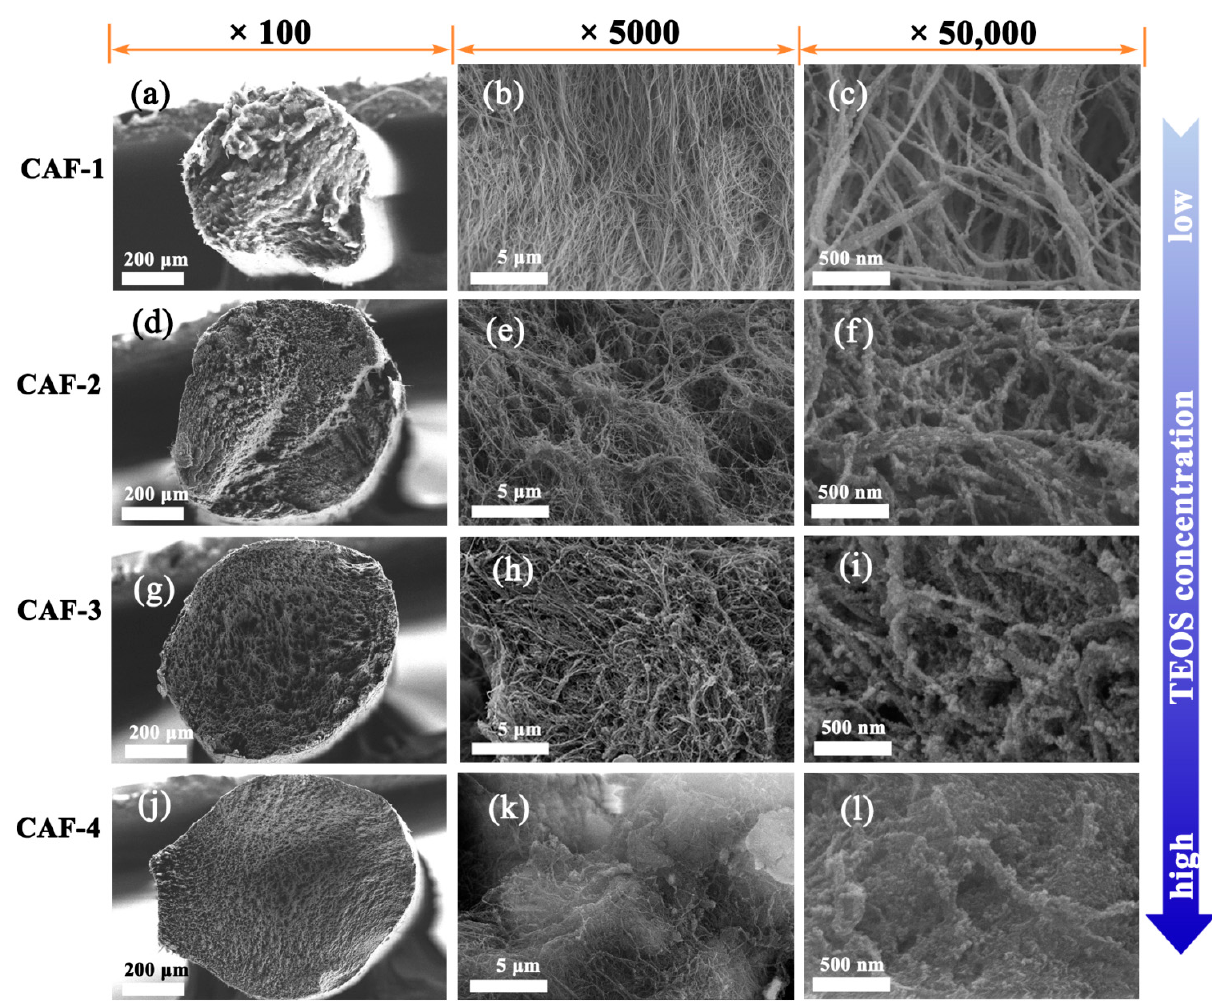
Figure 3. The SEM images of CAF-1 ( a – c ), CAF-2 ( d – f ), CAF-3 ( g – i ), and CAF-4 ( j–l ) with different magnifications.